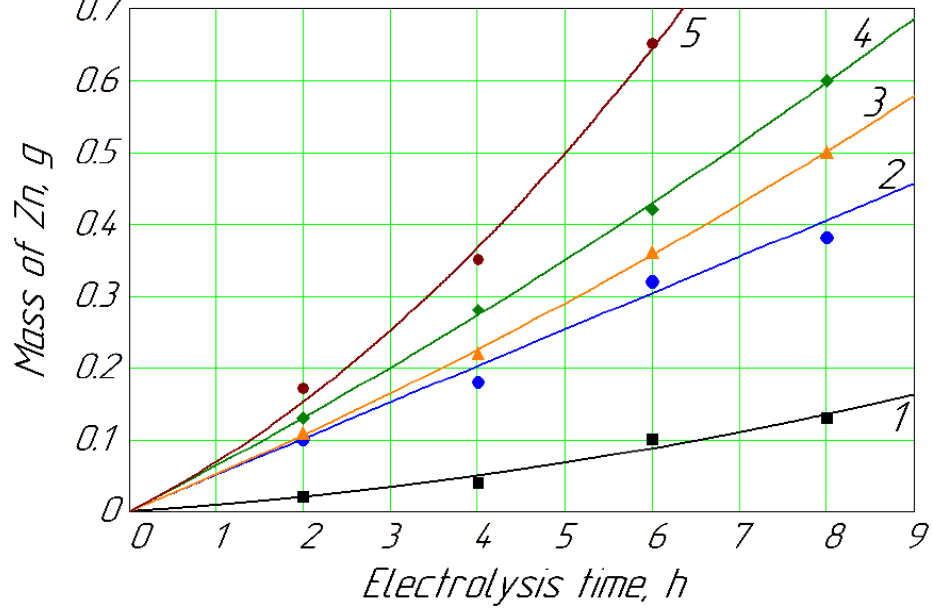
Figure 3. Mass of Zn deposited on the cathode vs. time for different concentrations of Zn 2+ in anolyte: 1, 0.013 mol/L; 2, 0.018 mol/L; 3, 0.022 mol/L; 4, 0.027 mol/L; 5, 0.089 mol/L.